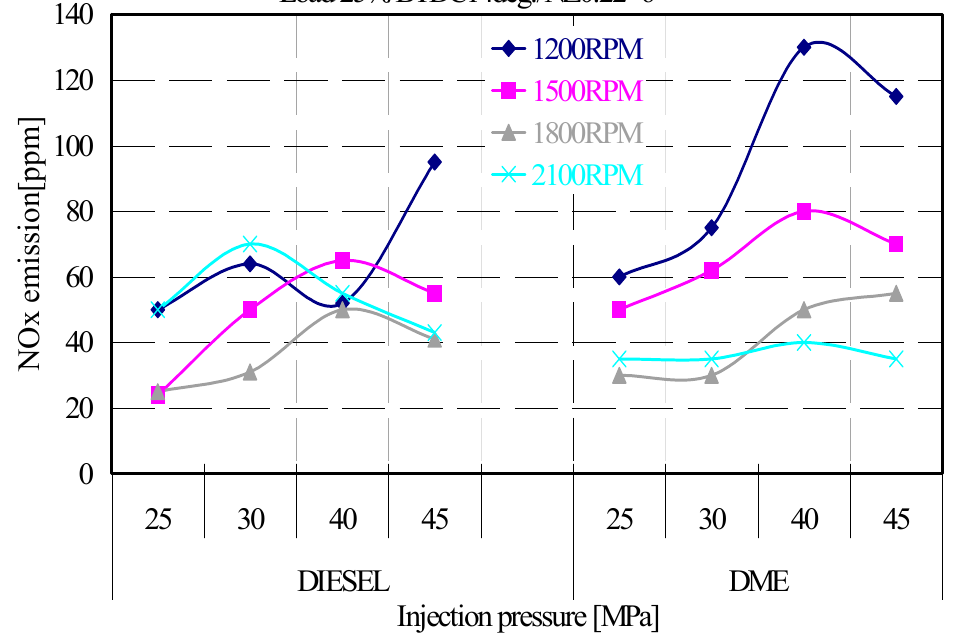
Figure 4. NO x emission characteristics of diesel and DME engines without pilot injection as a function of injection pressure and engine speed.